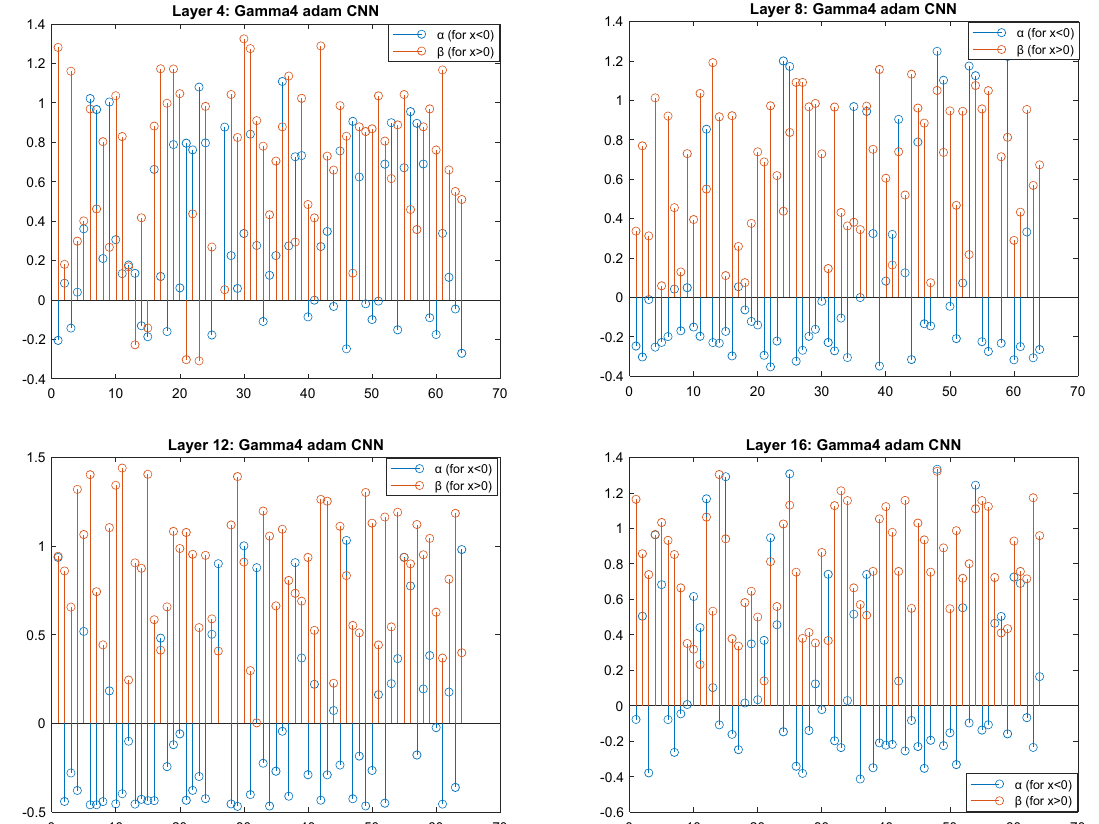
Figure 9. Pictorial representation of α and β values for a trained model at different layers for gamma4_adam network using Adam optimization. Here α and β are channel-wise learnable parameters in SGT layers, each corresponding to 64